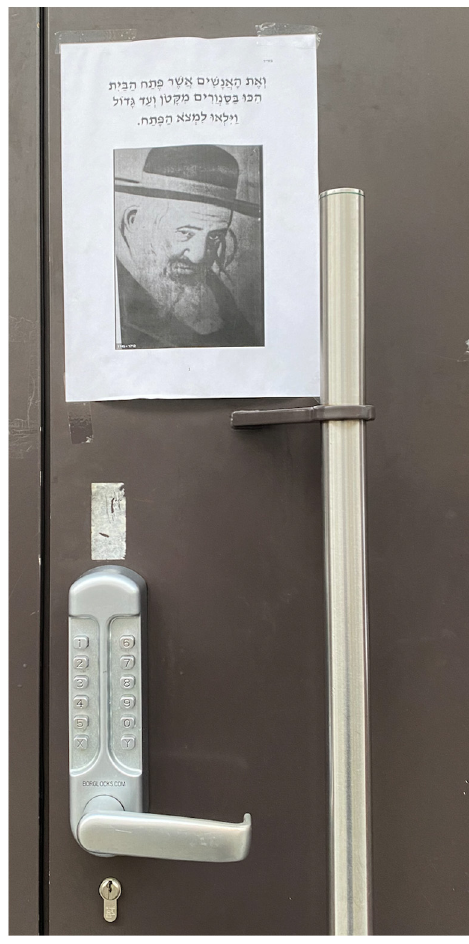
Figure 4. Reb Shayele in Antwerp. An image of Reb Shayele below a biblical verse (Genesis 19:5) on the front of a Hasidic synagogue in Antwerp (Source: photographs by author).